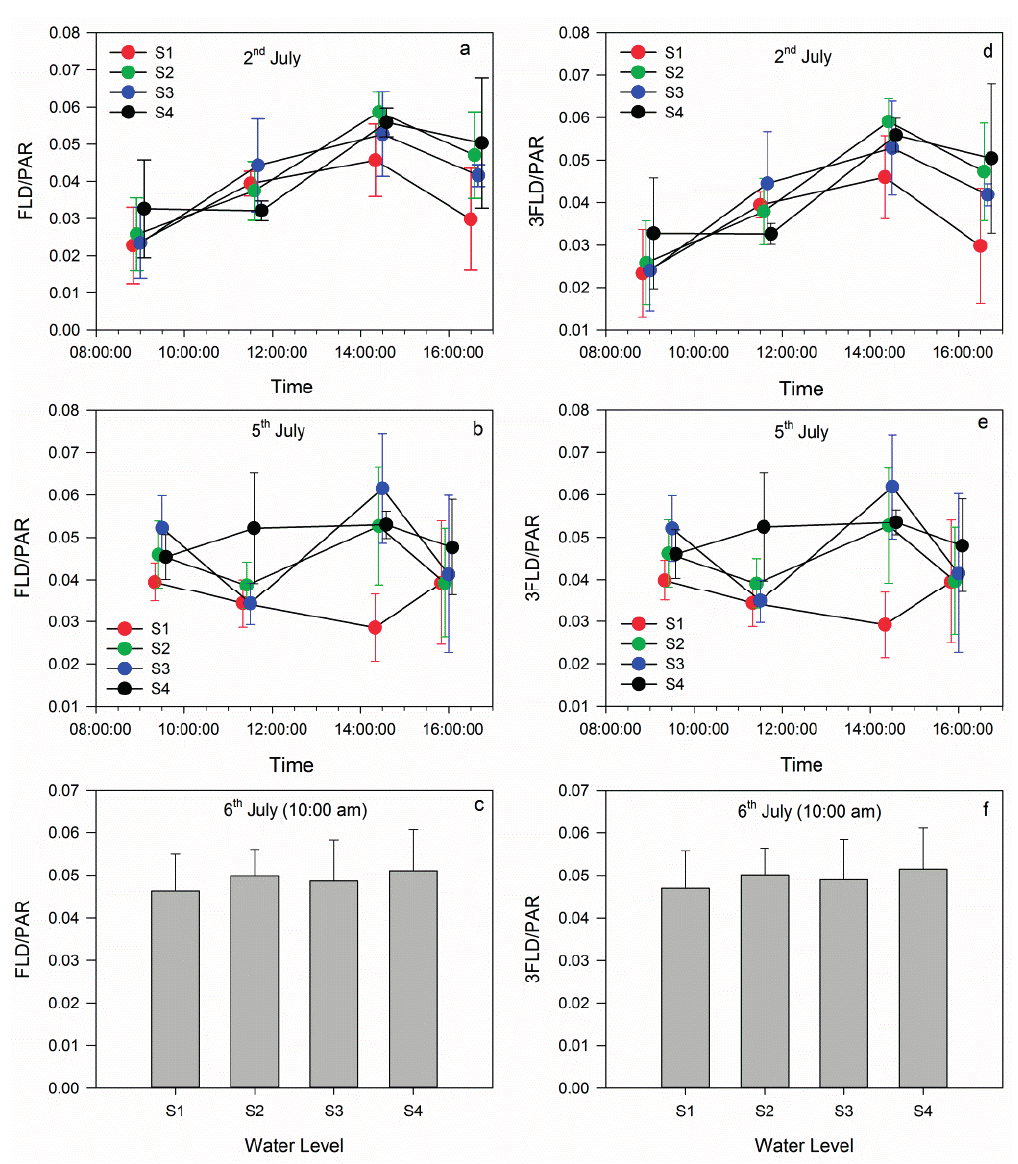
Figure 6. Daily variation in the fluorescence as retrieved by passive measurements: ( a ), ( b ) and ( c ): variations in the fluorescence using FLD on 2, 5 and 6 July; ( d ), ( e ) and ( f ): variations in the fluorescence using 3FLD on 2, 5 and 6